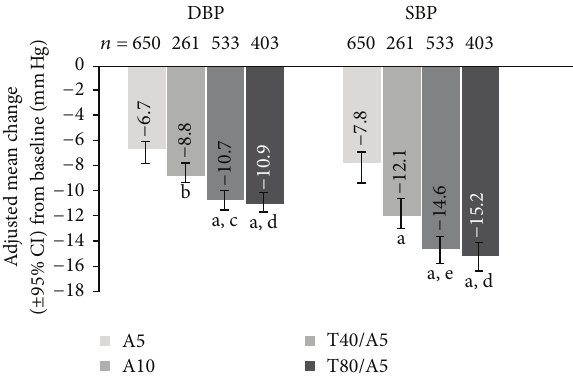
Figure 1: Adjusted mean change in DBP and SBP at week 8 from baseline in patients uncontrolled on A5 monotherapy. A5: amlodipine 5mg; A10: amlodipine 10mg; CI: confidence interval; DBP: diastolic blood pressure; SBP: systolic blood pressure; T40: telmisartan 40mg; T80: telmisartan 80mg. a 𝑃 < 0.0001 versus A5; f 𝑃 < 0.0001 versus A10.